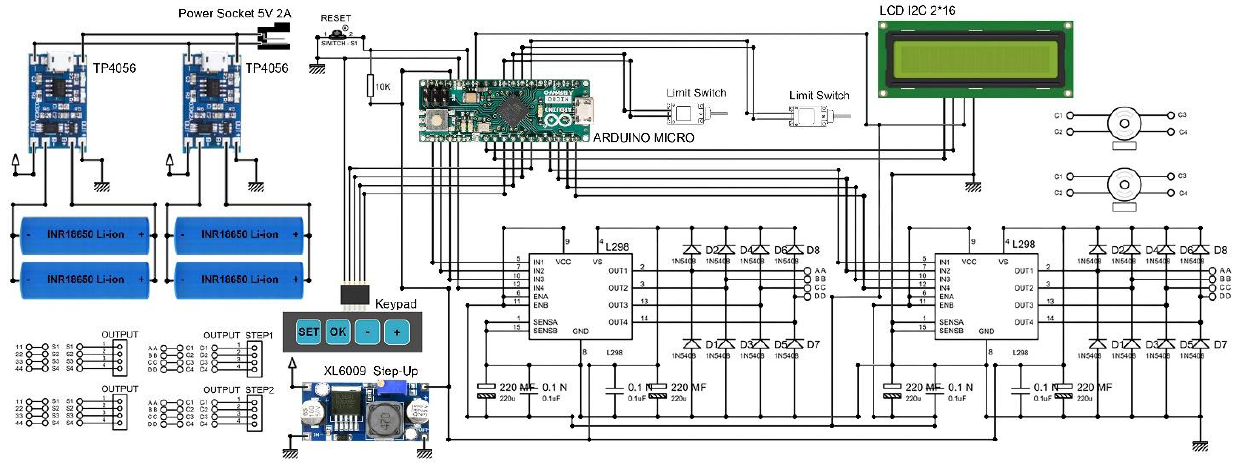
Figure 5. The detailed design of the control system.